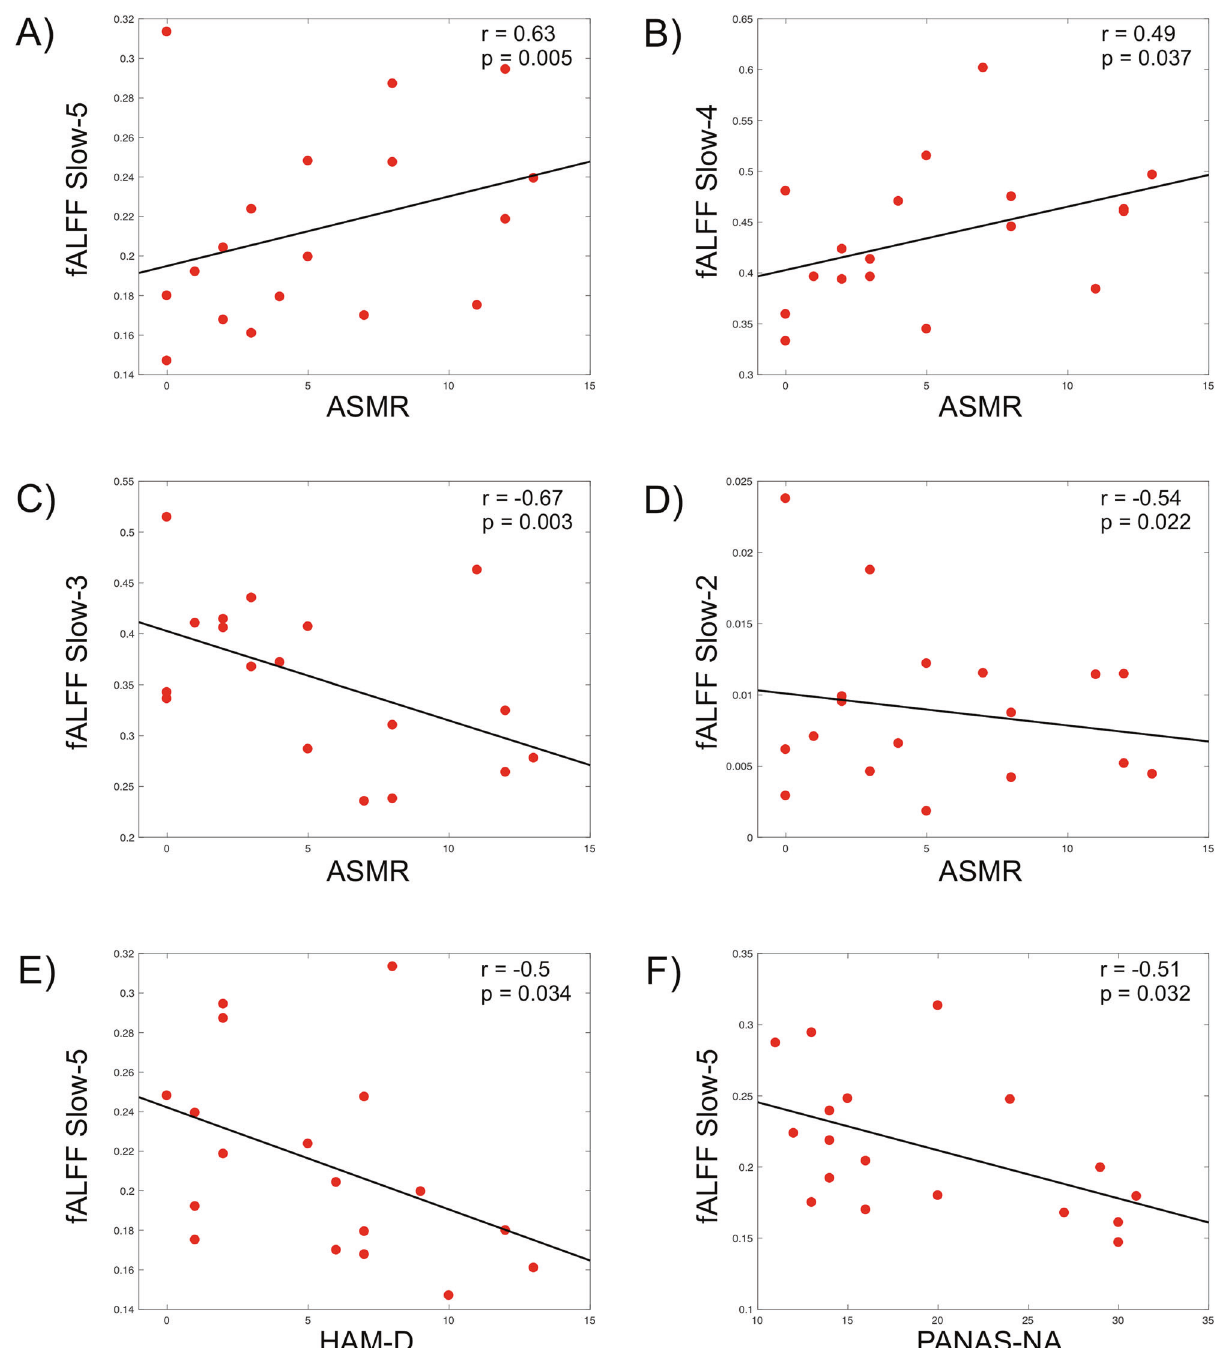
Fig. 3 Correlations between LN fALFF in BD patients and clinical symptoms. Signi fi cant Pearson correlations between all normalized fALFF bands (LN analysis) and ASMR mania symptoms severity ( A – D ), and between Slow-5 and both depressive symptoms severity (HAM-D scores; E ) and pessimistic attitude (PANAS-NA scores; F of brain functioning at rest, especially in psychiatric disorders. The between-group t maps. Despite the lack of evident symptoms in integration of the two methods provided a spatial description of euthymic patients, we expected to fi nd a potential marker of the LN functioning, together with the abnormal linguistic (a)symme- hidden disorder by studying an altered LN functioning, that is try, which has been linked to psychosis etiopathogenesis. In line lower LN fALFF power spectral activity in the left vs . right with Crow ’ s hypothesis [17, 18], we investigated brain functional hemisphere. To the best of our knowledge, this is the fi rst study alterations associated with BD condition in the LN, an issue that that studied the resting-state properties of LN in BD patients in the received little attention in previous literature. From our results, an euthymic state using fALFF. The combination of information altered spatial pattern emerged in the LN. This network related both to connectivity patterns and the spectral power of encompassed regions in the frontal right operculum, including neuronal activity might play an important role in the investigation